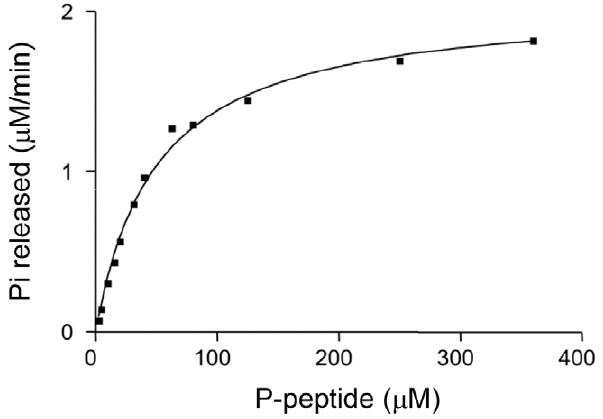
Figure 8. Determination of Km of phosphatase RPTP c on peptide substrate ATQDD(pY)VLEVR (derived from peptide adjacent to Y1307). Figure here shows Pi released (microM per minute) was plotted against phospho-peptide in a reaction in which Vmax was 2.1 m M/mim/14 nM RPTP c and Km is 49.6 m M, using one site nonlinear binding algorithm in Graphpad